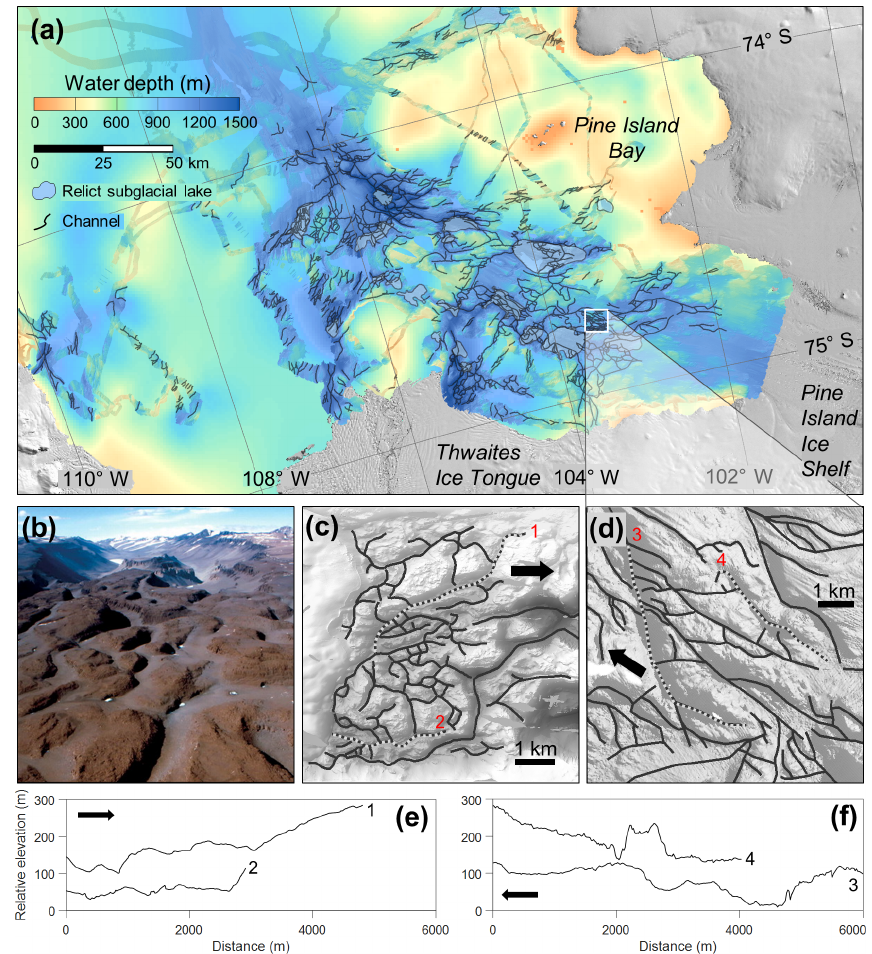
Figure 3. Channelized bathymetry of the region offshore of Pine Island and Thwaites glaciers. (a) Inner-continental-shelf bathymetry within Pine Island Bay, gridded at a 20m cell size with sun illumination from the northeast. Mapped channels are displayed as black lines, and mapped relict subglacial basins are displayed as blue polygons. Onshore topography is displayed as a shaded Landsat Image Mosaic of Antarctica (LIMA) (U.S. Geological Survey, 2007). The white square in (a) is scaled to the same dimensions as the Labyrinth, displayed in (b, c) . (b) Oblique aerial photograph of the channel system comprising the Labyrinth (Lewis et al., 2006). Channels in the foreground are ∼ 100m wide. (c) Digital elevation model of the Labyrinth with channels displayed as black lines. (d) Subset of the Pine Island Bay bathymetry, scaled to the same dimensions as the Labyrinth, exhibiting a series of channels. Black arrows denote the inferred direction of palaeo ice flow. Selected long profiles of the channels comprising the Labyrinth (e) and in Pine Island Bay (f) with numbers denoting their locations in (c, d) . Vertical exaggeration in (e, f) is 50 ×